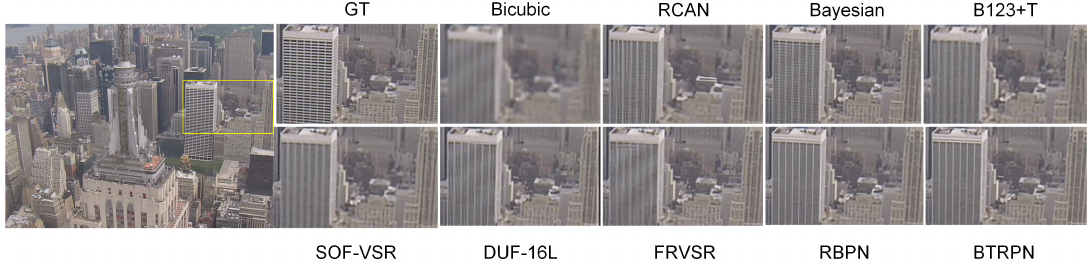
Figure 9. Qualitative comparison on the city clip for 4 × video SR. GT is the abbreviation of ground